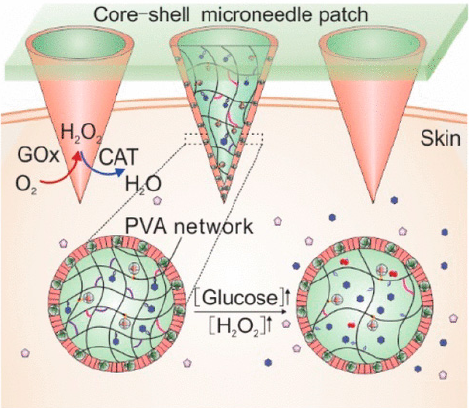
Figure 7. Mechanism of glucose-stimulated insulin release via glucose oxidase in a microneedle array patch. Adapted with permission from [65]; Published by ACS Nano, 2018.